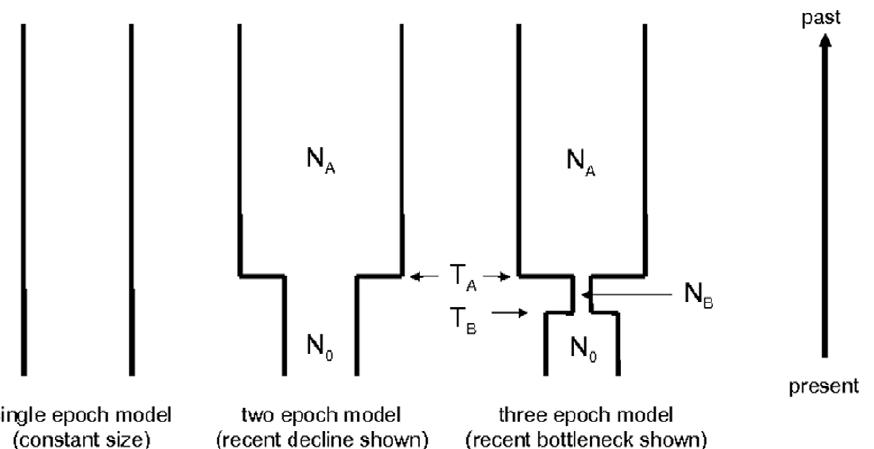
Figure 1. Bottleneck models tested. N 0 , N B and N A refer to current, during bottleneck and before bottleneck effective population sizes, while T A and T B refer to time in 2N 0 generations to the change from N B to N 0 and from N A to N B , respectively. doi:10.1371/journal.pone.0014234.g001 PLoS ONE |